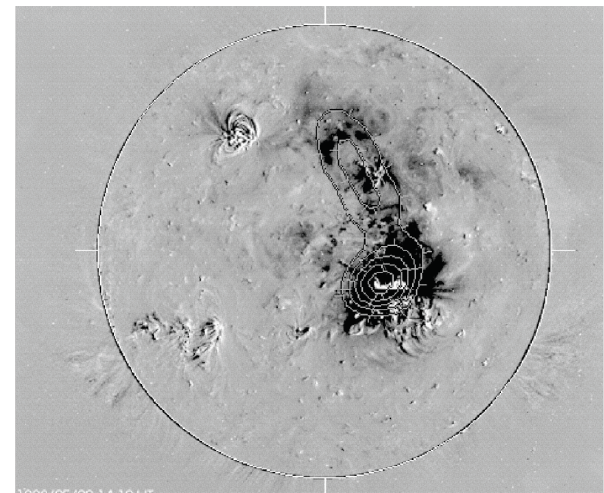
Fig. 3. From Maia et al. (1999) on 6 November 1997 CME event showing that the angular width of the CME is comparable to the spatial extent of the radio emission (i.e. the bright regions on the solar disc and over the west limb).